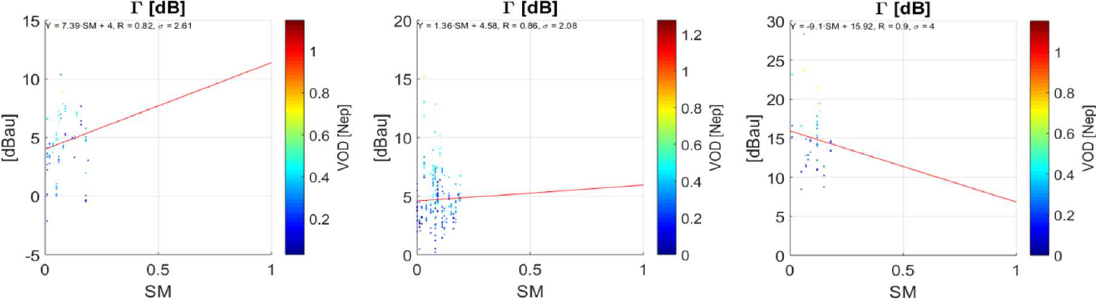
Figure 16. Same as Figure 16, but over CEMADEM/Brazil, using a radius of ~30 km from the soil moisture stations. Note the limited range of Soil Moisture values, as this region corresponds to the so-called Brazilian semi-arid.